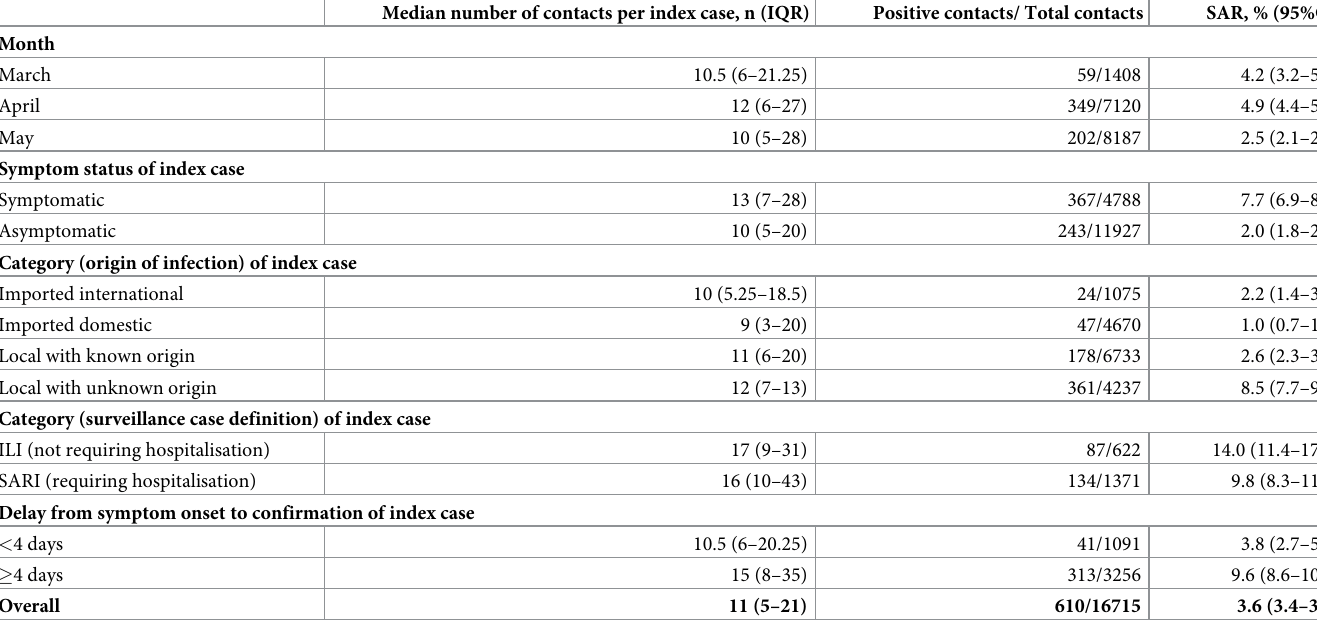
Table 2. Secondary attack rate of SARS-CoV-2 among 16715 contacts of 956 index cases (Karnataka, India; up to 1 June 2020). Median number of contacts per index case, n